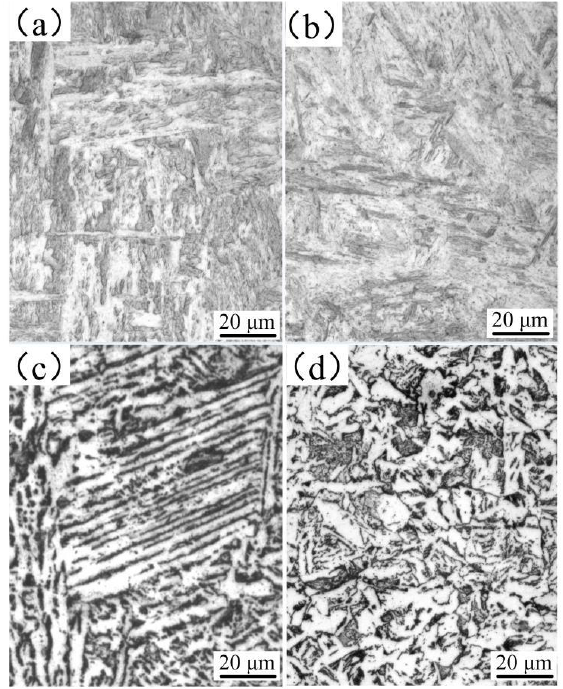
Figure 11. Microstructures of the weld. ( a ) Microstructure of the upper weld; ( b ) microstructure of the lower weld; ( c ) microstructure of the heat-affected zone, and ( d ) microstructure of the base material.